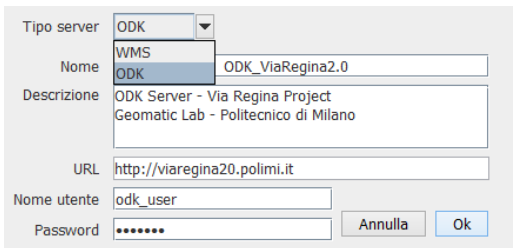
Figure 6. Form to connect transparently to any WMS or ODK server available on the network